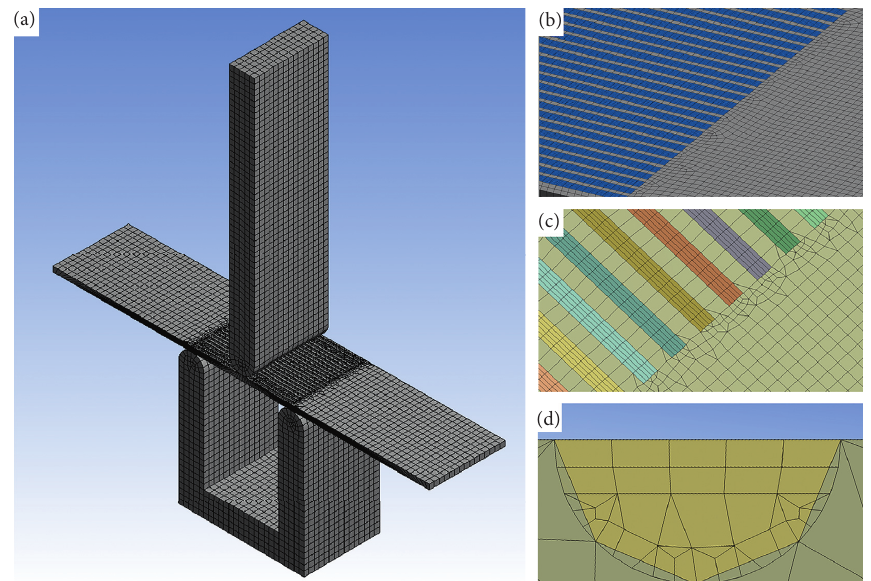
Figure 1: Finite element mesh of a model in Ansys workbench: (a) general view of 3D mesh, (b) enlarged view of mesh of laser tracks, (c) enlarged view of surface mesh of treated area, and (d) cross-sectional view of mesh of individual laser